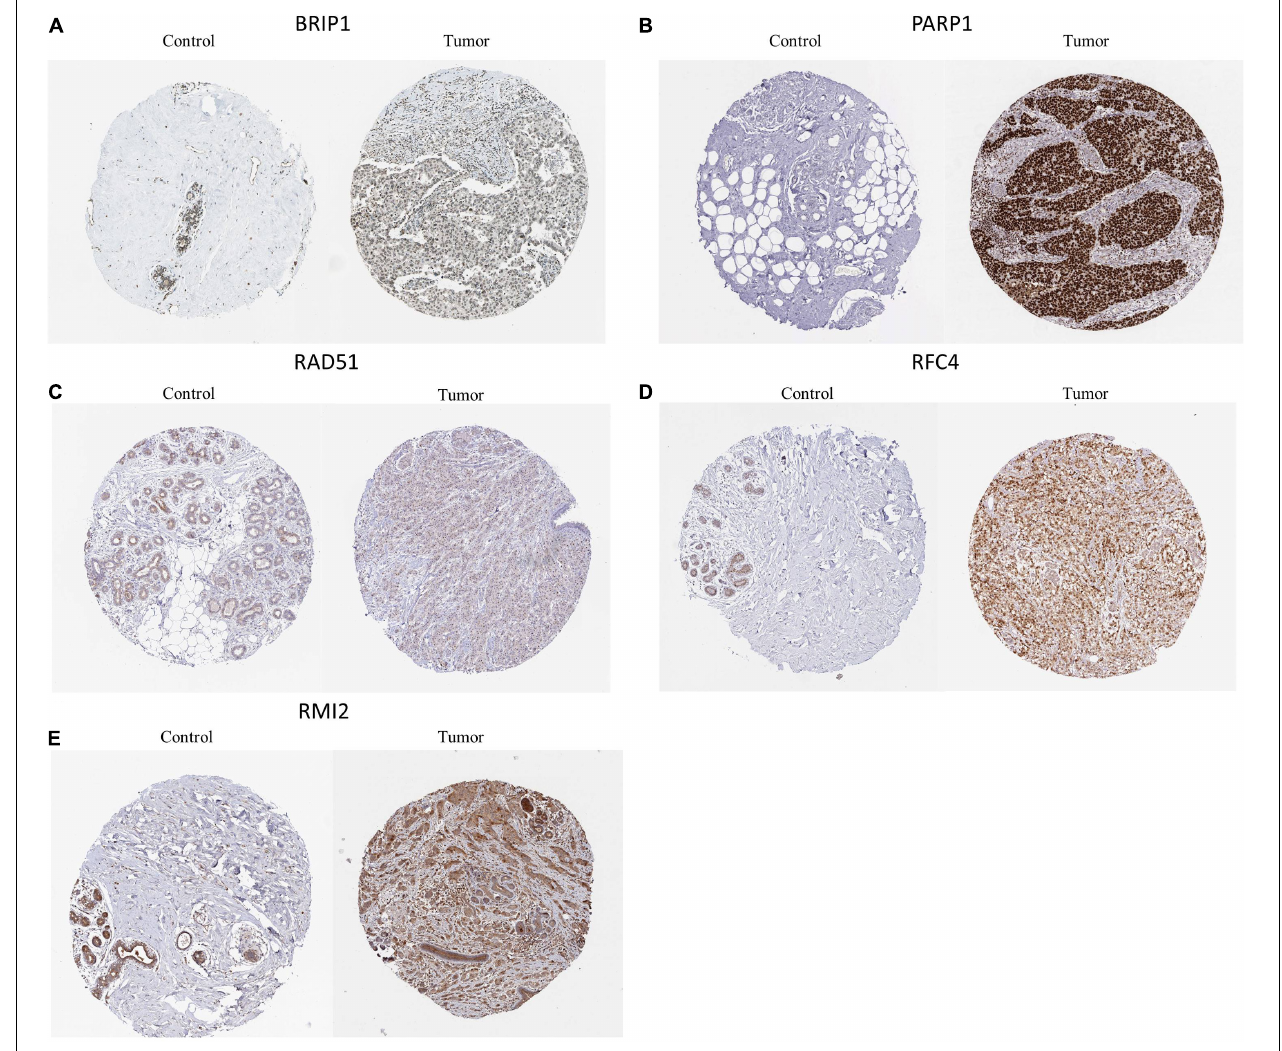
FIGURE 7 | Representative immunohistochemical stains of the six prognostic genes analyzed in the HPA data. (A) BRIP1 protein expression in breast cancer and normal control samples. (B) PAPR1 protein expression in breast cancer and normal control samples. (C) RAD51 protein expression in breast cancer and normal control samples. (D) RFC4 protein expression in breast cancer and normal control samples. (E) RMI2 protein expression in breast cancer and normal control